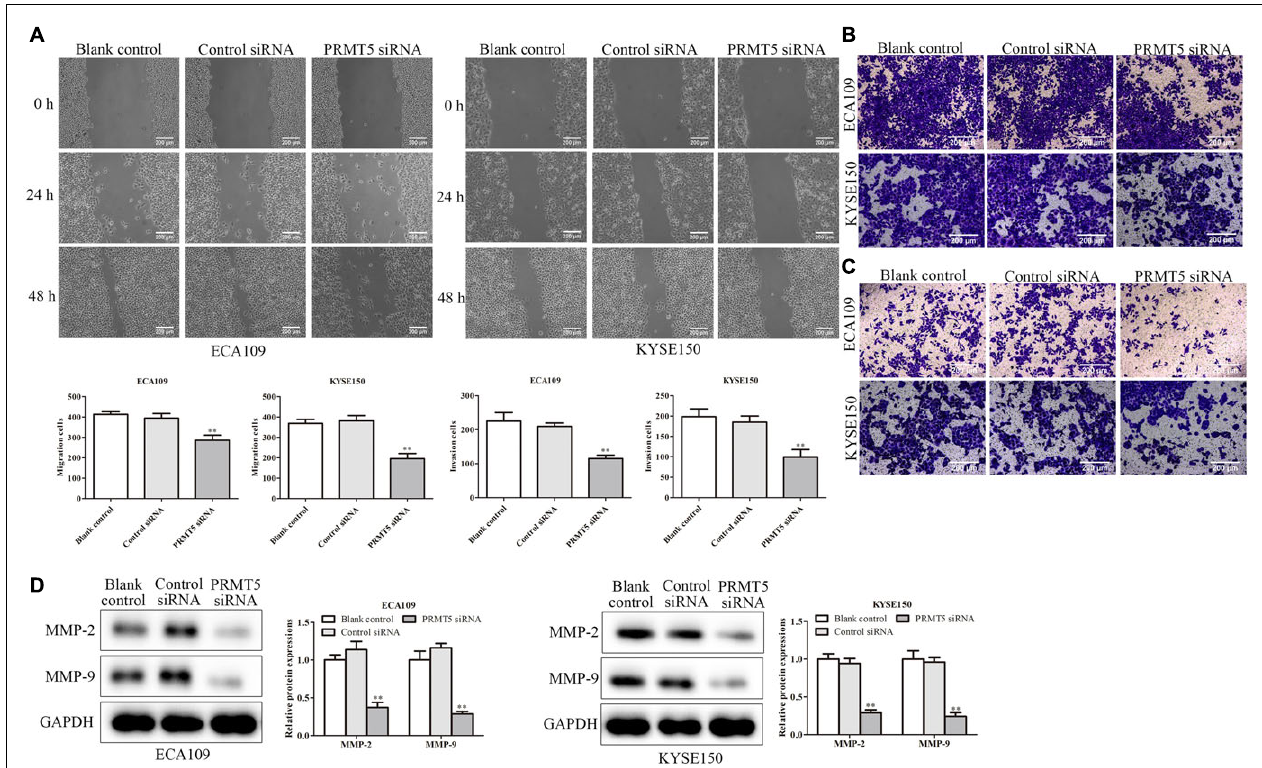
FIGURE 4 | PRMT5 promoted ESCC cell migration and invasion. (A) Wound-healing assay indicated that knocking down PRMT5 expression effectively inhibited cell mobility. The photographs were taken at the magnification of × 40. (B,C) Transwell migration and invasion assay showed that knocking down PRMT5 expression suppressed the migration and invasion abilities of ECA109 and KYSE150 cells. The photographs were taken at the magnification of × 200. (D) The expression levels of MMP-2 and MMP-9 were analyzed in ECA109 and KYSE150 cells. GAPDH was used as a control. Bars indicate the mean ± SEM, * P < 0.05, ** P < 0.01 vs. control siRNA. PRMT5, protein arginine methyltransferase 5; ESCC, esophageal squamous cell